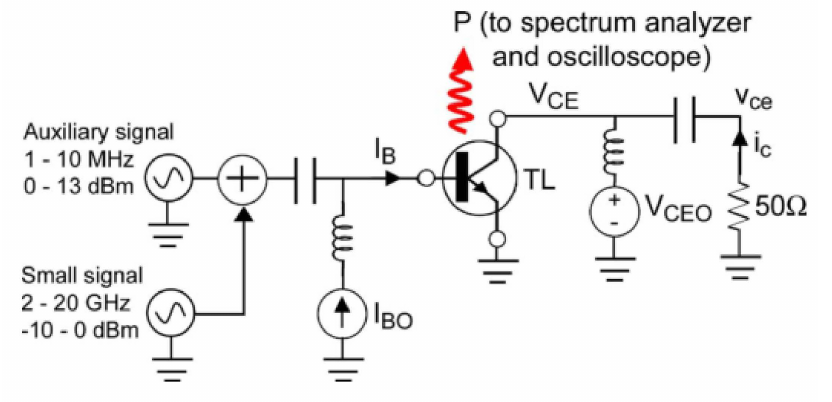
Figure 12. Low-frequency auxiliary AC signal to improve TL optical bandwidth circuit diagram [74]. Reproduced from Ref. [74], with the permission of AIP